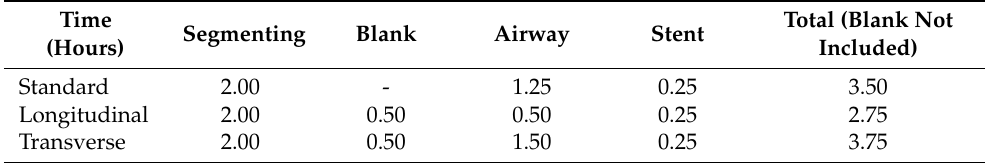
Table 3. Time savings between standard and alternative methods in